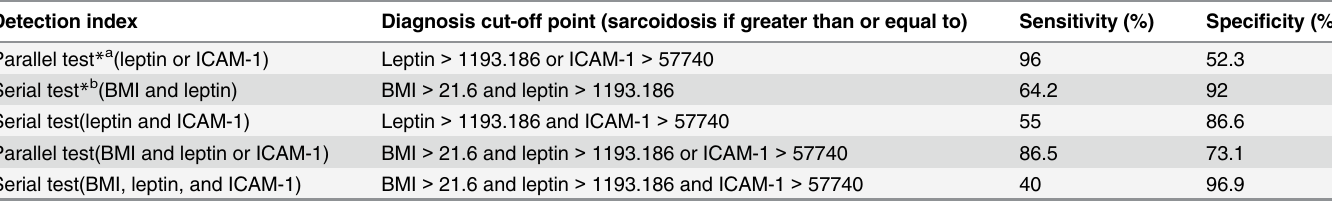
Table 7. Sensitivity and specificity of the parallel and serial tests for differential diagnosis of SA and TB. Detection